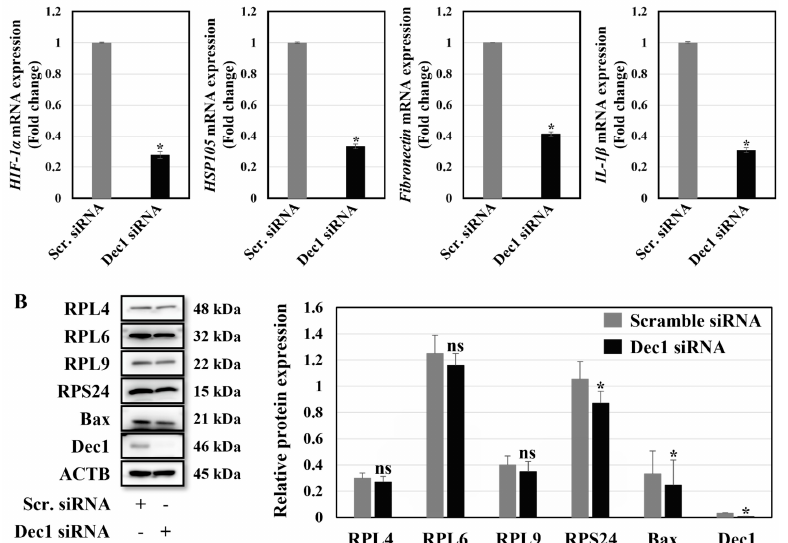
Figure 12. Dec1 knockdown inhibits the expression of ribosomal proteins in hPDL fibroblasts in a hypoxia environment. ( A ) Quantitative RT-PCR analysis reveals that the expression levels of ribo- somal proteins, HIF-1 α , HSP105, fibronectin and IL-1 β are reduced in Dec1 siRNA transfected hPDL fibroblasts. The data shown represent means ± SD; * p < 0.05. All results are representative of exper- iments done in triplicate. ( B ) Western blot analyses reveal the suppressed expression of RPL4, RPL6, RPL9, RPS24, and Bax in the Dec1 siRNA transfected hPDL fibroblasts. The data shown represent the means ± SD of experiments carried out in triplicate; * p < 0.05. ns, not significant.